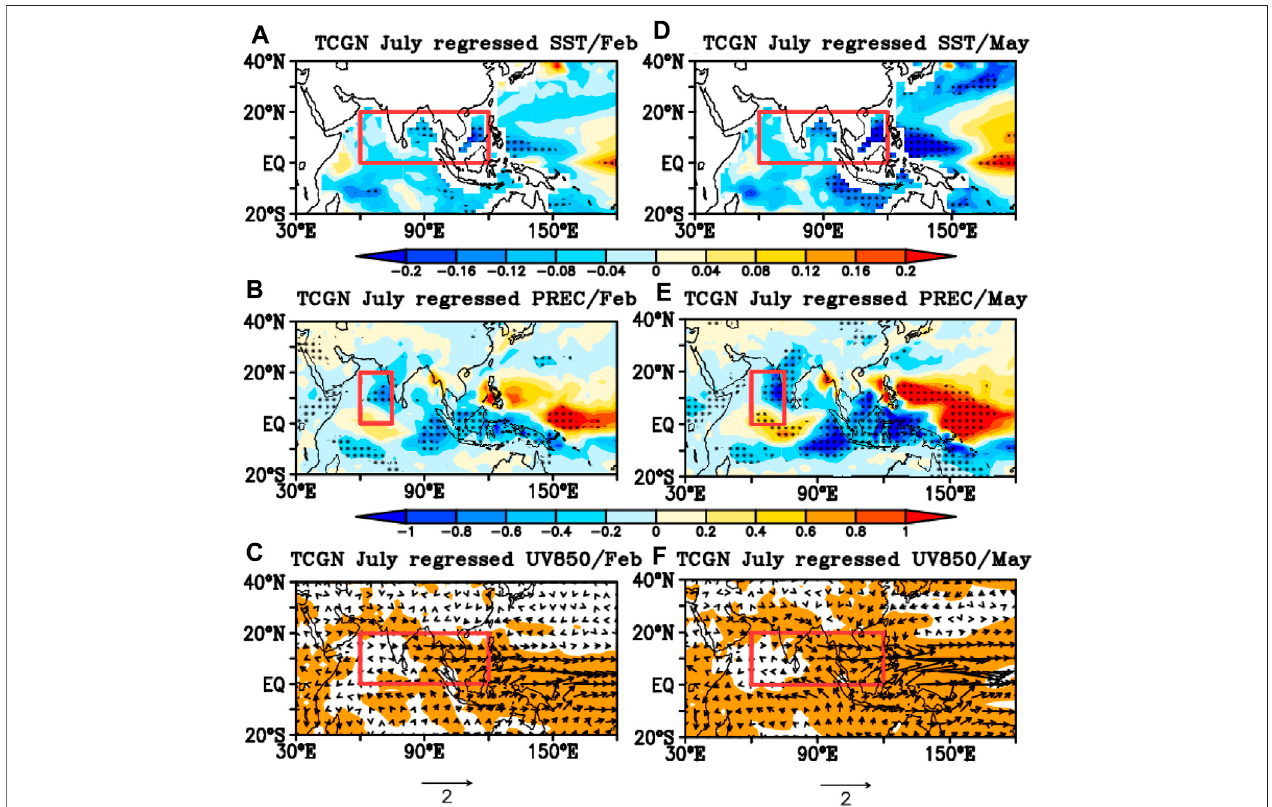
FIGURE15 | Regression patterns of theCFSv2-predicted July (a, d)SSTanomaly (units:K) (b, e)precipitation anomaly (units: mm/day), and (c, f)UV850anomaly (units: m/s), at (A – C) 4- and (D – F) 2-months leads, upon the standardized July TCGN during 1982 – 2020. Dotted (a, b, d, e) and shaded (c, f) areas indicate statistical signi fi cance at the 95% level, as estimated by a Student ’ s t -test. The regions marked by the red rectangle are used to de fi ne SSTI-NIO (0 ° – 20 ° N, 60 ° – 120 ° E), PRECI (0 ° – 20 ° N, 60 ° – 75 ° E), and U850I (0 ° – 20 ° N, 60 ° – 120 °